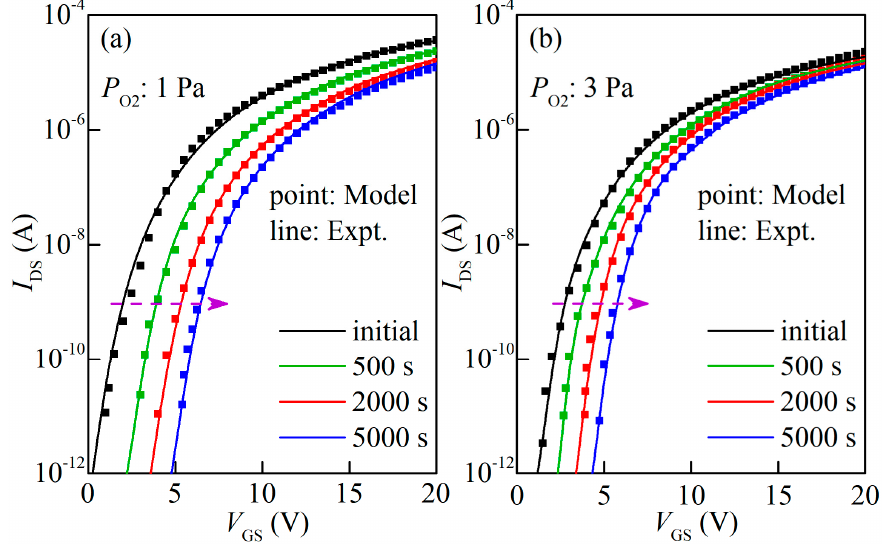
Figure 6. Measured evolution of the transfer curves as a function of PBS time for a-IGZO TFTs fabricated with different Po 2 values compared with model results: ( a ) 1 Pa and ( b ) 3 Pa.